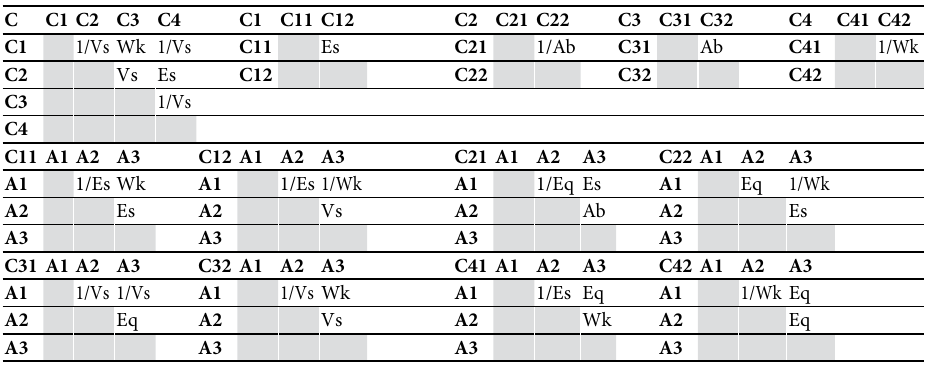
Table A2. Pairwise matrices of Expert 2